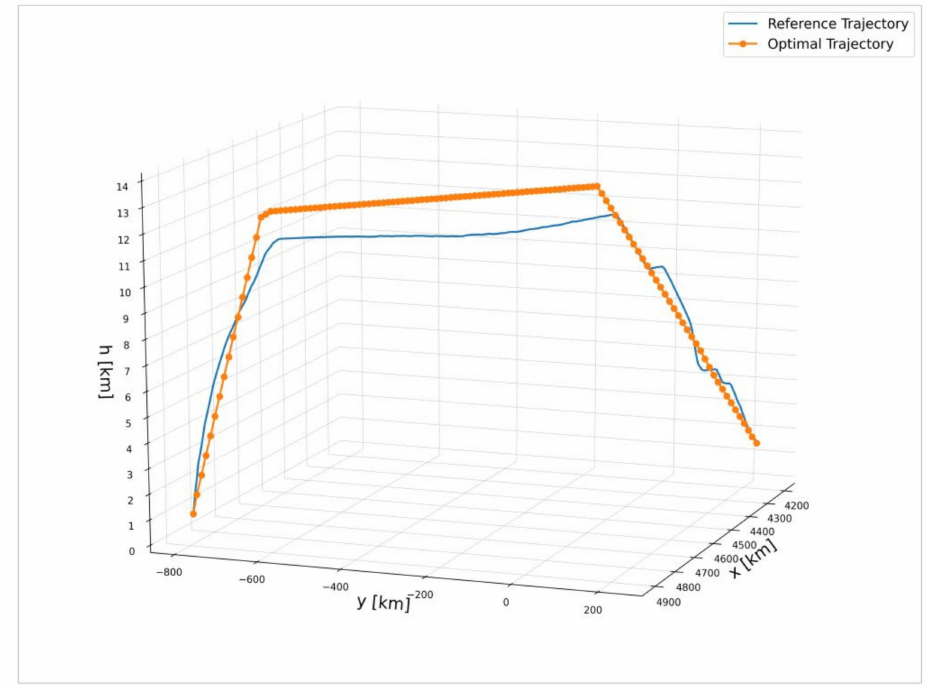
Figure 3. Comparison of reference and fuel optimal 3D trajectories.